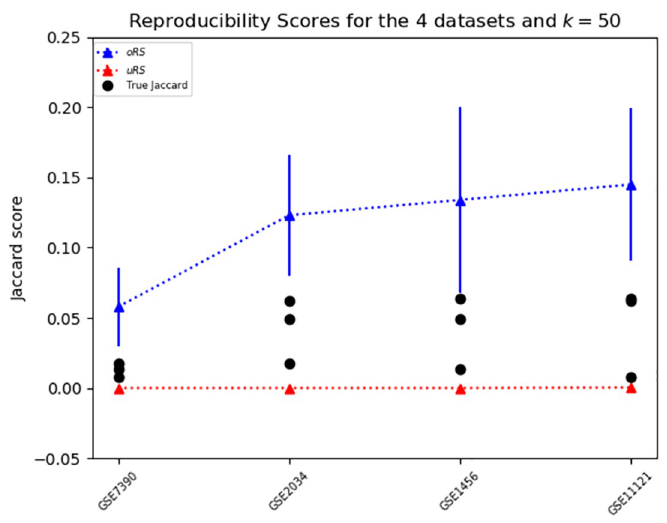
Fig 7. Empirical results for continuous datasets. Reproducibility scores (mean and standard deviation) for all 18 continuous datasets, both for complete datasets with n subjects (left) and for half-sized with n iterations. The x-axes (for both plots) are sorted by the value of the over-bound for the D ( n ) datasets. We see, in both, that the over-bound oRS is consistently higher than the under-bound uRS. Moreover, the right plot shows that the “truth” c RS is also between uRS and oRS. (The bRS lines in the plots are based on the Bootstrap Overbound method; see Section C.1 in S1 Appendix).